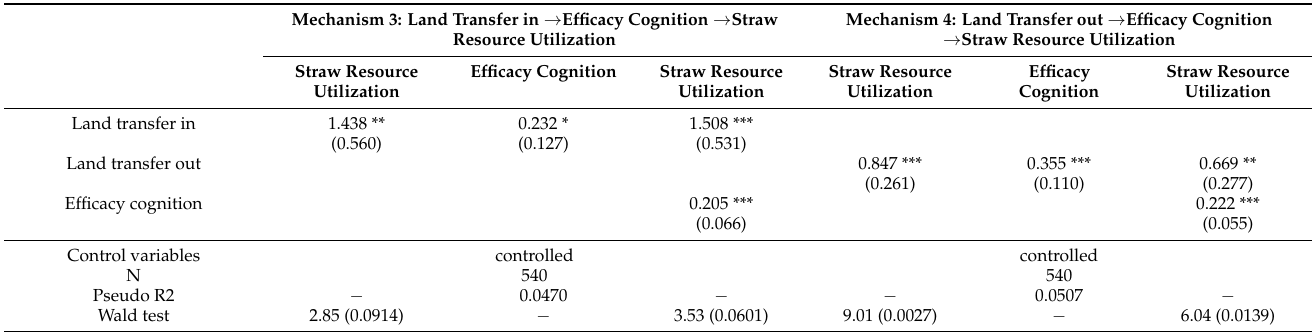
Table 7. Analysis of mediating mechanism of efficacy